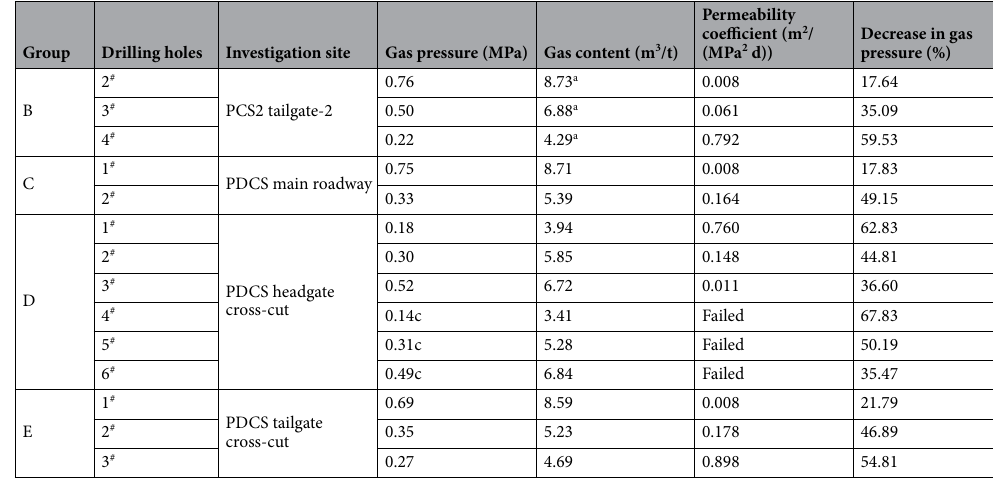
Table 3. Field measurements of the gas pressure and gas content after protective coal seam mining. a Using Eq. (9) to calculate the gas content or gas pressure.